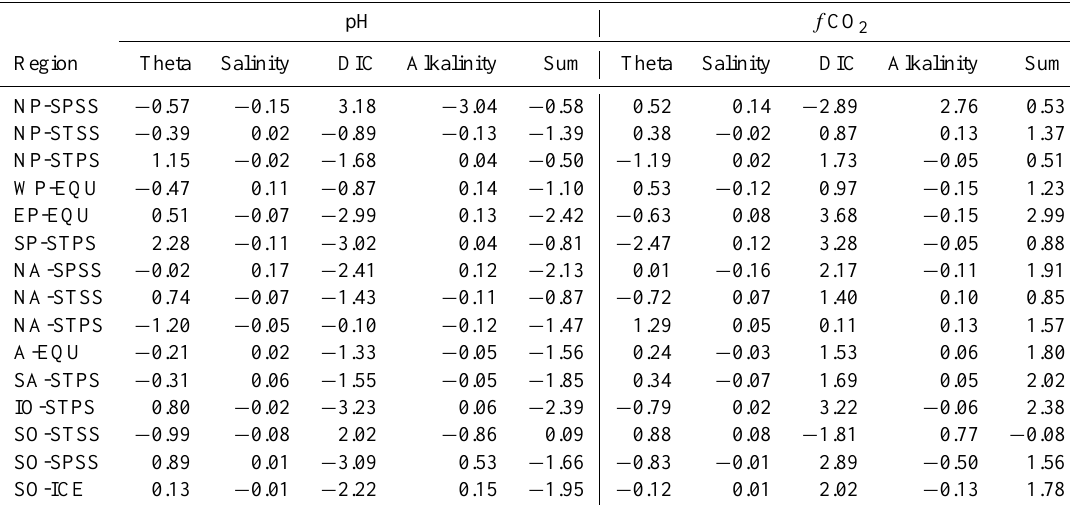
Table 2. Decomposition of the f CO 2 and pH insitu trends into their major drivers. The units are µatmyr − 1 and 10 − 3 pH unitsyr − 1 respec- tively.